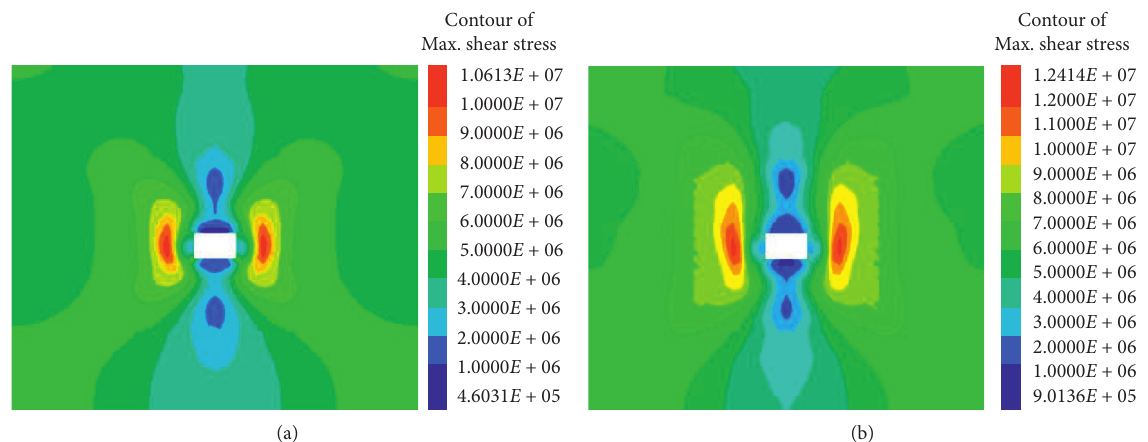
Figure 7: Distribution diagram of surrounding rock shear stress before and after disturbance. (a) Before applying disturbance load. (b) After applying disturbance load.